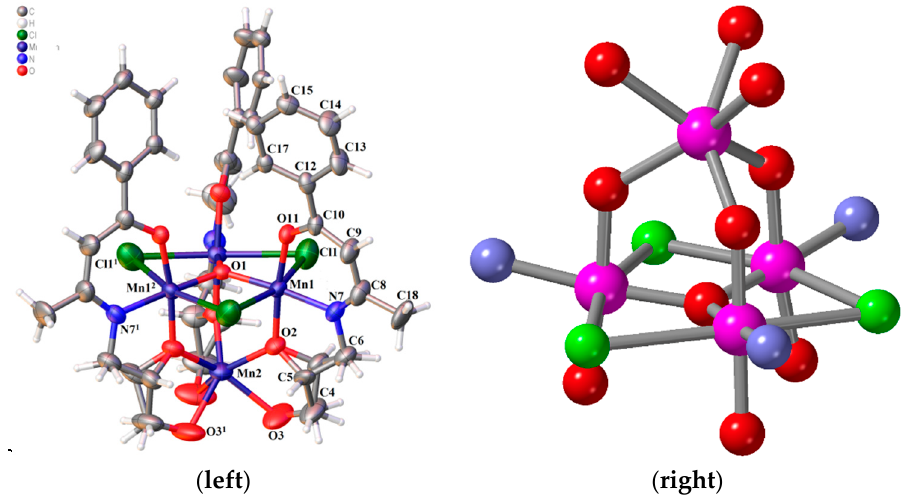
( left ) ( right ) Figure 2. ( left ) Perspective view of the compound 1 with atom labels. ( right ) View of atetrahedral Mn 4 core with coordinating atoms in compound 1 . Symmetry operations: 1 = 1 − y, x − y, z; 2 = 1+y − x, 1 − x, z. Table 1. Relevant bond distances (Å) and angles (°) for compound 1 .